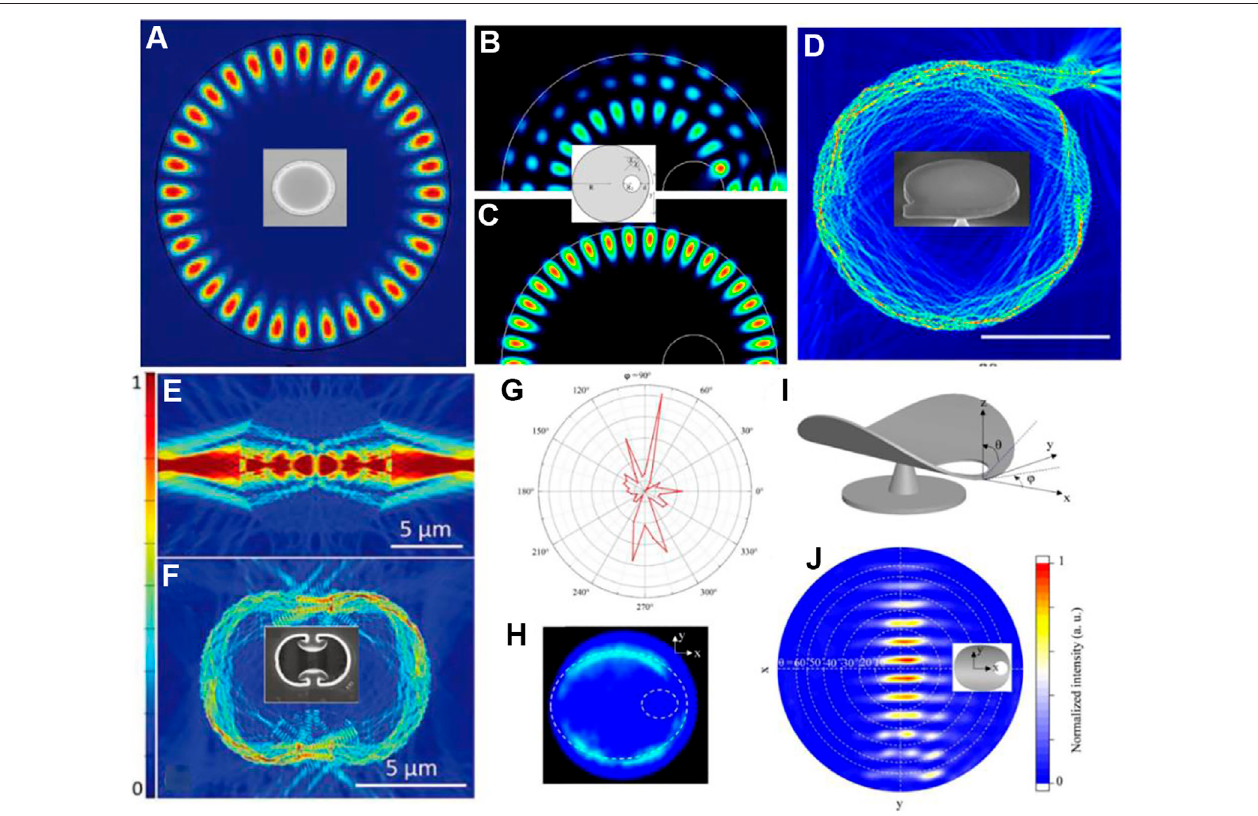
FIGURE 6 | FDTD simulation results of a (A) microdisk (Tamboli et al., 2007), (B,C) microdisk with a hole (Wiersig and Hentschel, 2006), (D) GaN microdisk with a corner(Zhuetal.,2017),and (E,F) GaNPenrosemicrocavity(Zhuetal.,2019). (G) PLintensityofthelasermodeat441.3 nminvariousdetectionangles. (I) Illustrationof warpedmicrodisksina3Dsphericalcoordinatesystem. (H) CCDimageofthewarpedmicroring. (J) Far- fi eldpatternofthewarpedmicroringcalculatedbyFDTD(Zhang et al., 2021). Reprinted with permission © Nature Publishing Group (Tamboli et al., 2007), © American Physical Society (Wiersig and Hentschel, 2006), ©